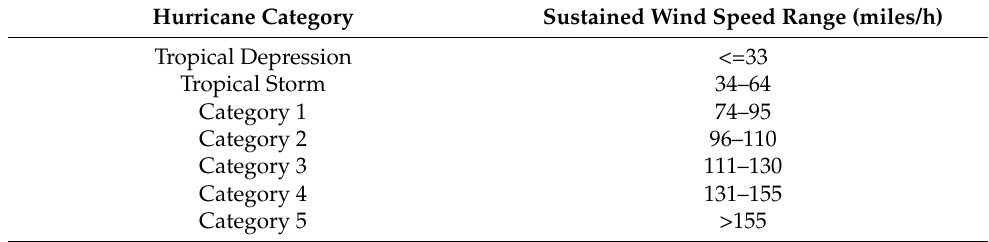
Table 3. Categories of